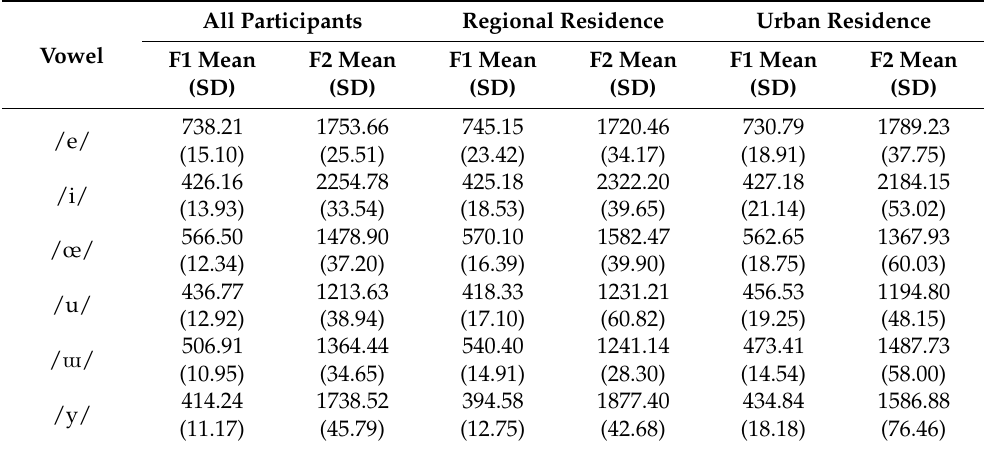
Figure 3. Mean F1 and F2 values for the vowels /i y e œ ɯ u/ produced by L1 AmE speakers (in blue), superimposed over the mean F1 and F2 values for the vowels produced by a native female speaker of Standard Istanbul Turkish (in orange). Table 4. Descriptive statistics of F1 and F2 values (in Hertz) of target vowels for all participants and by residence